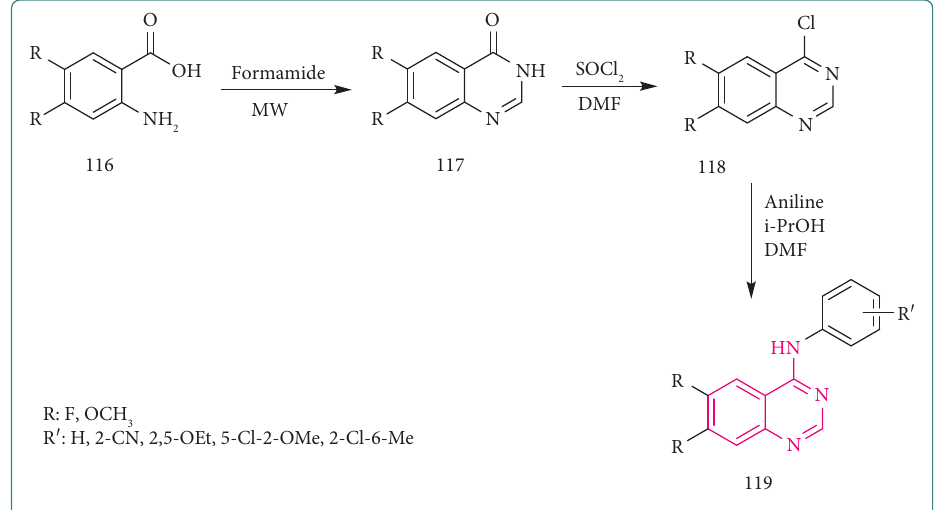
Scheme 21: Synthesis of 4-aminoquinazolines derivatives using ortho -difouro or ortho -dimethoxy anthranilic acid under microwave irradiation